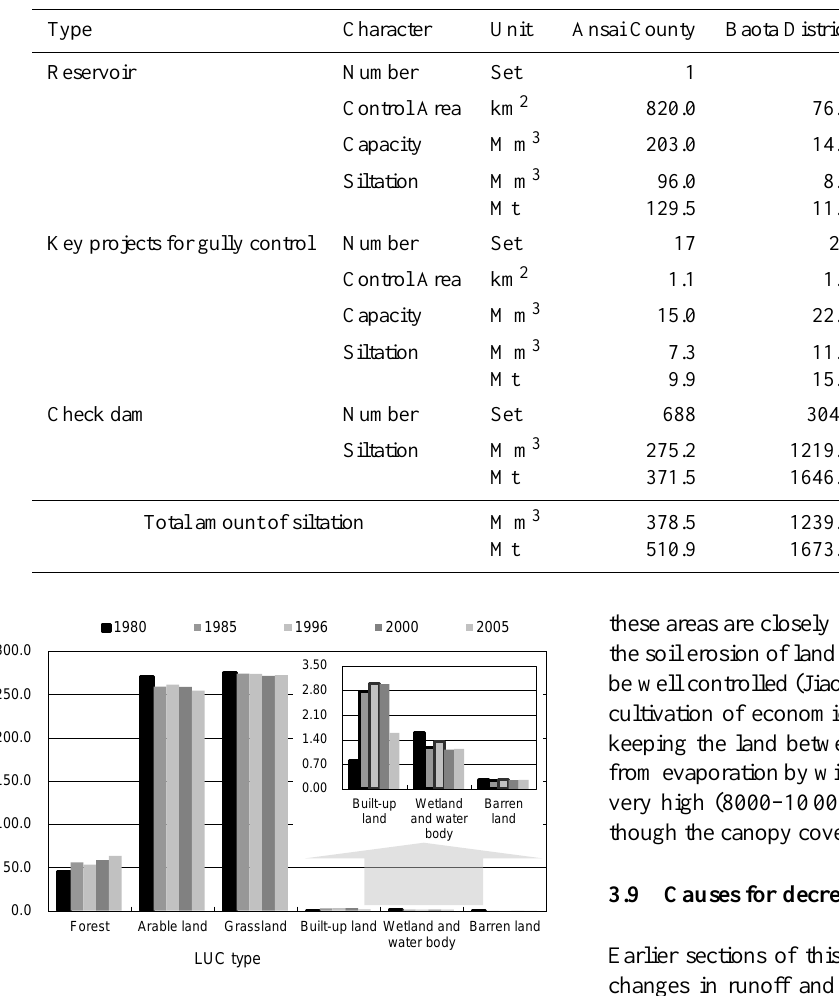
Fig. 6. LUC change in the Yan River Basin from 1980 to 2005